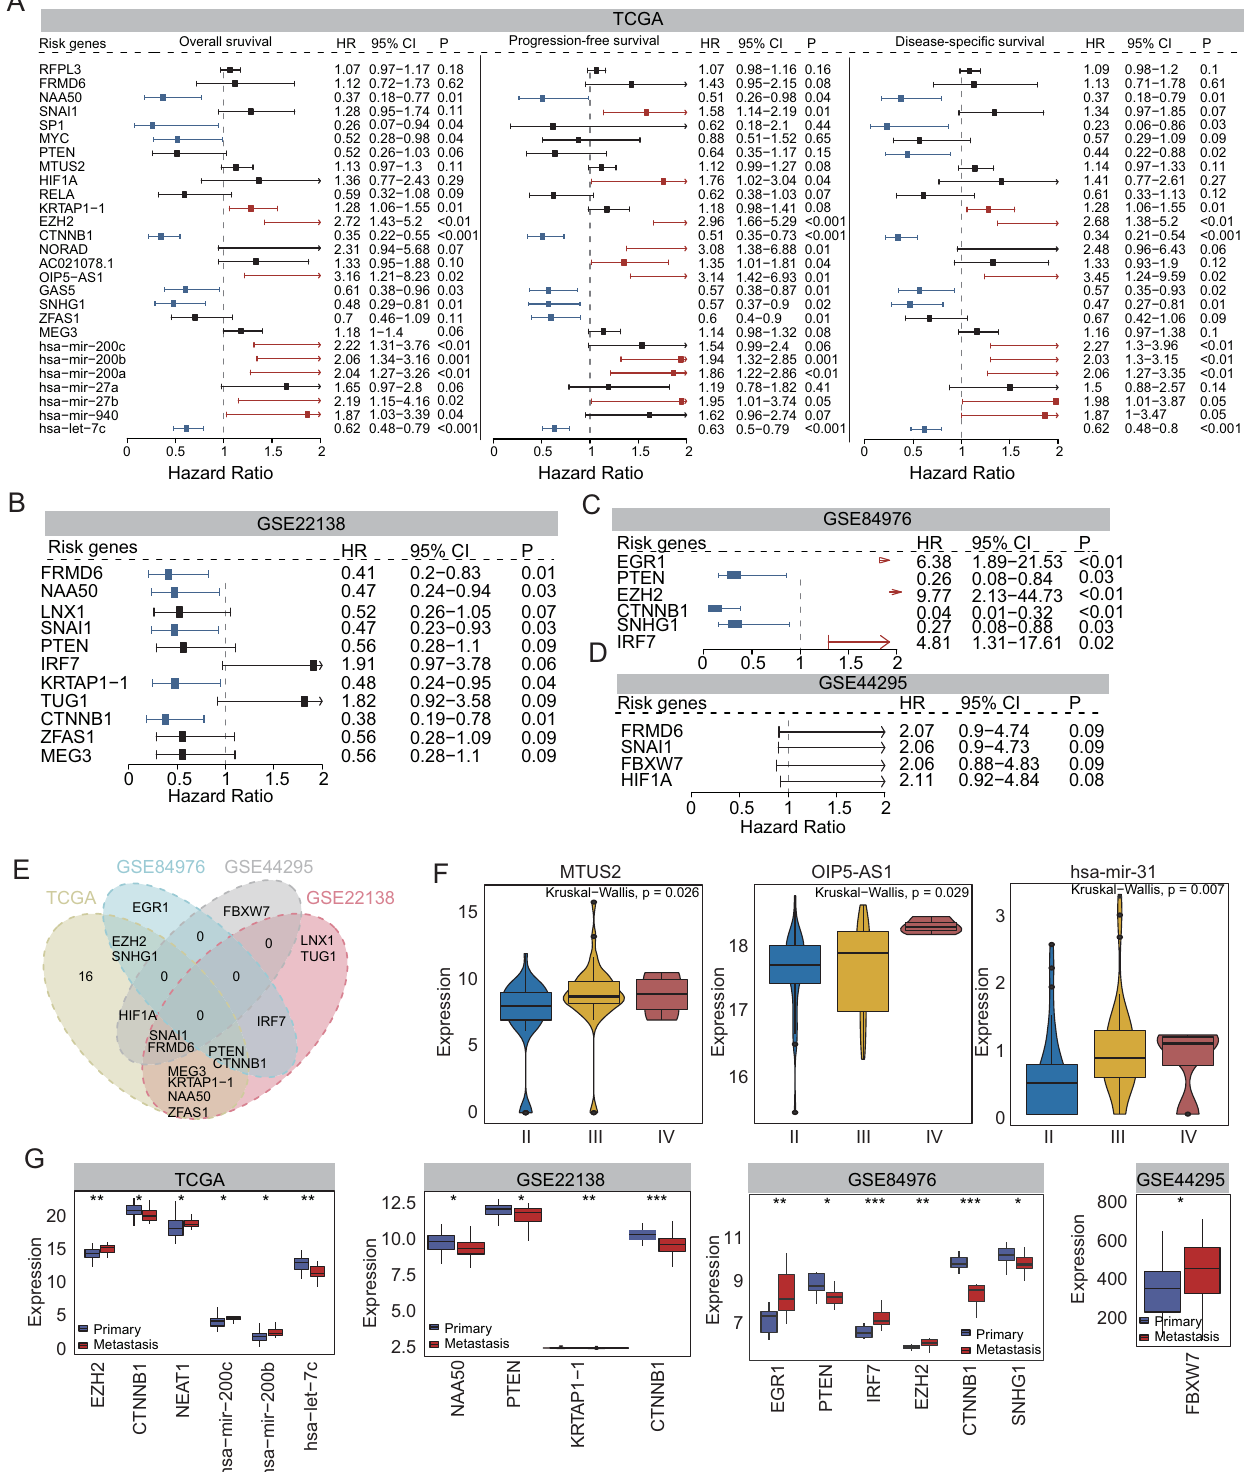
Fig. 4 Clinical validation of novel UM-related SGs. Forest plot visualizing the hazard ratios (95% con fi dence interval) of univariate Cox regression analysis for novel UM-related SGs in A TCGA, B GSE22138, C GSE84976, and D GSE44295 cohorts. E Venn diagram illustrating overlaps of prognostic genes among different patient cohorts. F Boxplot showing expression levels of stage-related SGs in TCGA cohort. G Boxplot showing expression levels of metastasis-related SGs in different patient cohorts. UM uveal melanoma, SGs susceptibility genes, TCGA The Cancer Genome